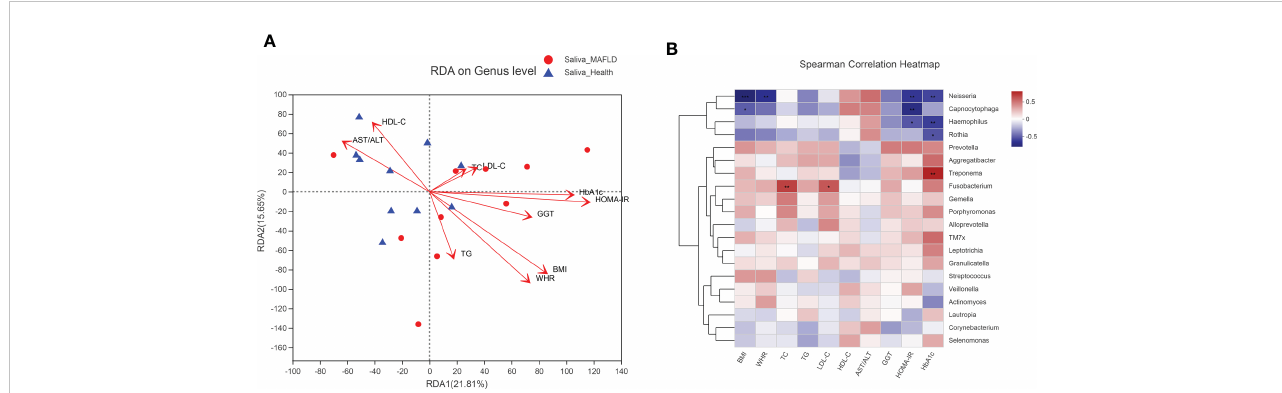
FIGURE 5 Correlation analysis between microbial community and clinical variables. (A) RDA analysis on microbial population distribution is explained by the clinical variables at the genus level. Arrows represent clinical variables. The long arrow indicates a high correlation with the distribution of the salivary microbiome. The acute angle of the two arrow lines indicates a positive correlation between the clinical variables, and the obtuse angle is a negative correlation. (B) Spearman correlation heatmap based on the top 20 abundant salivary microbiota and clinical variables. The color range on the right shows the color partitioning of the different R values. A clustering tree for each species is on the left side of the heat map. *P < 0.05; ** P < 0.01; *** P < 0.001